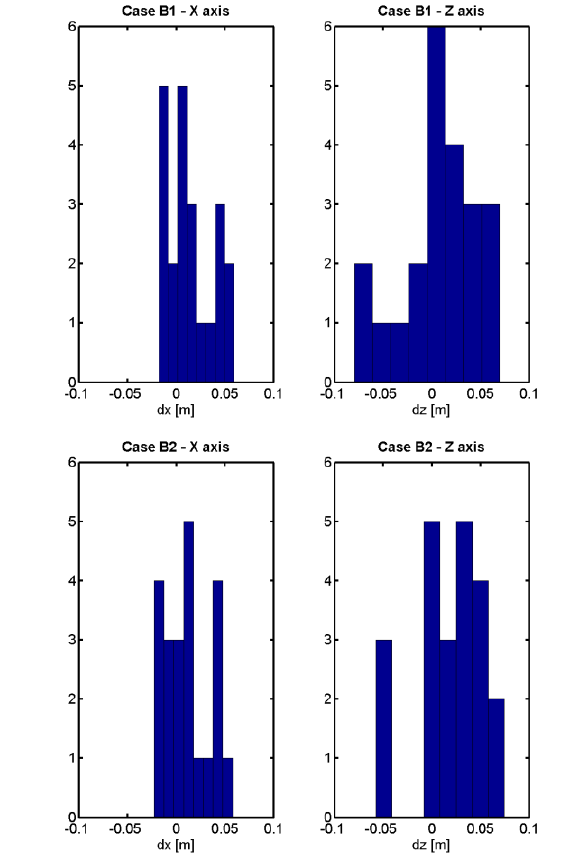
Figure 2. Case B: Histogram of residuals on 22